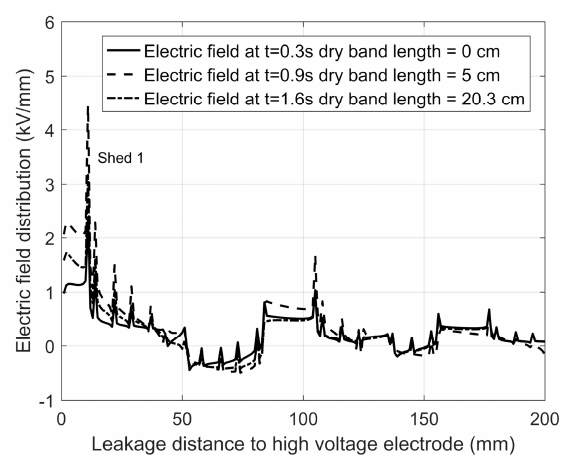
Figure 6. Electric field comparison with di ff erent lengths of the dry